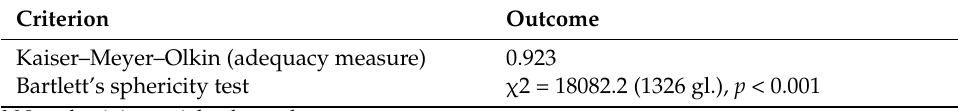
Table 6. Diagnostic criteria of the factor analysis ( n = 725) a .